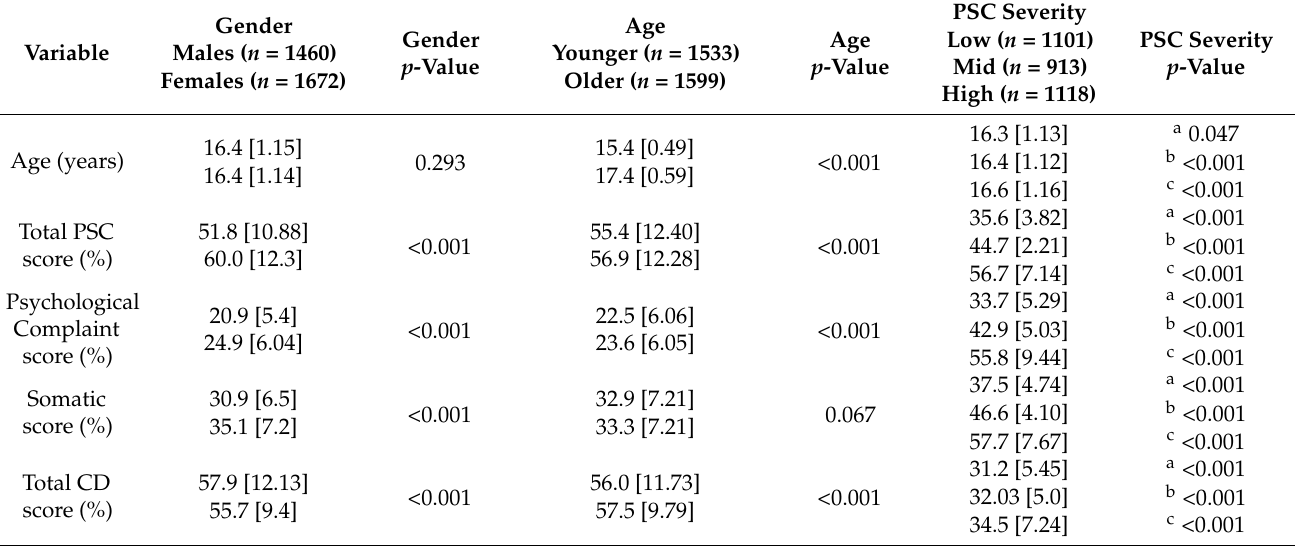
Table 3. ANOVA mean scores and standard deviations for each independent variable (Gender, Age, PSC Severity) on PSC and Total CD scores of the total Uppsala Cross-sectional Life and Health Young Survey (LHS) study cohort ( n =